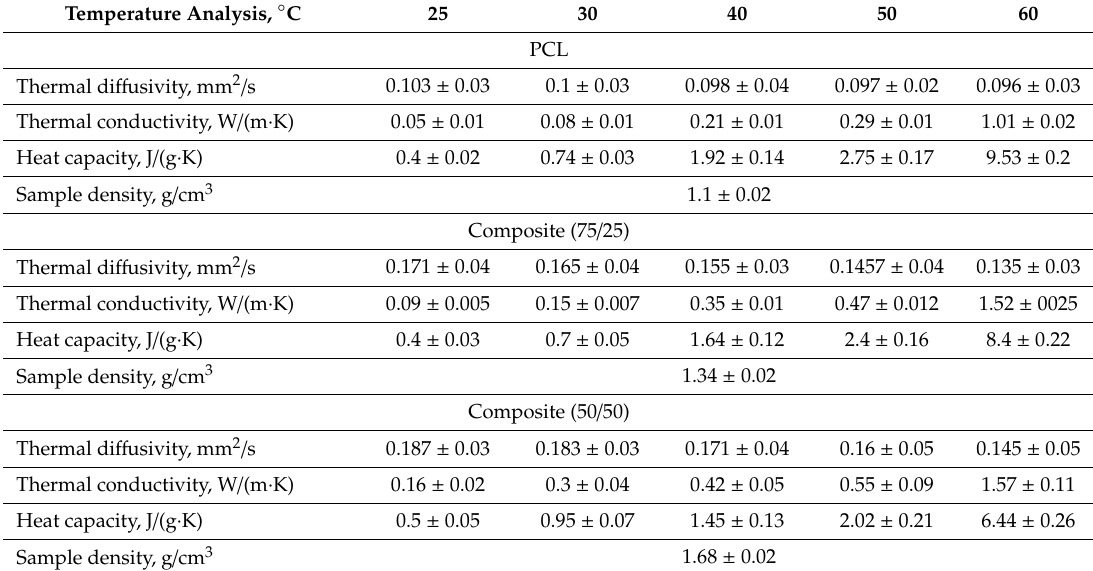
Table 2. Thermal properties and densities of the obtained samples.